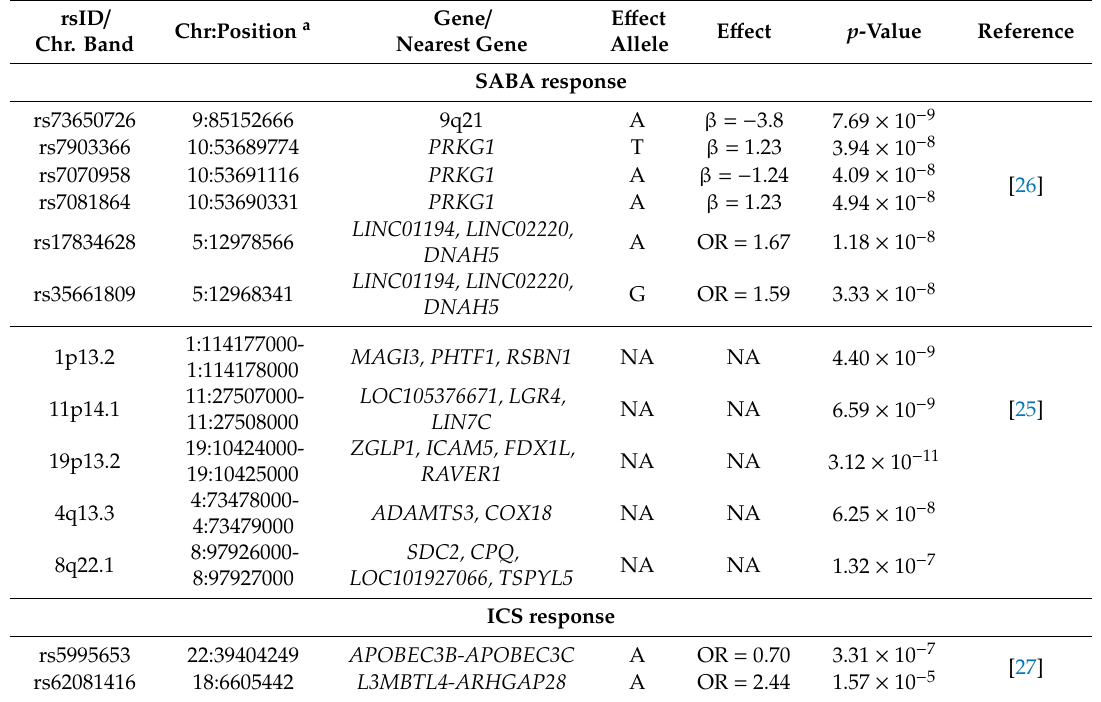
Table 1. Summary of the main recent findings of pharmacogenomic studies in childhood